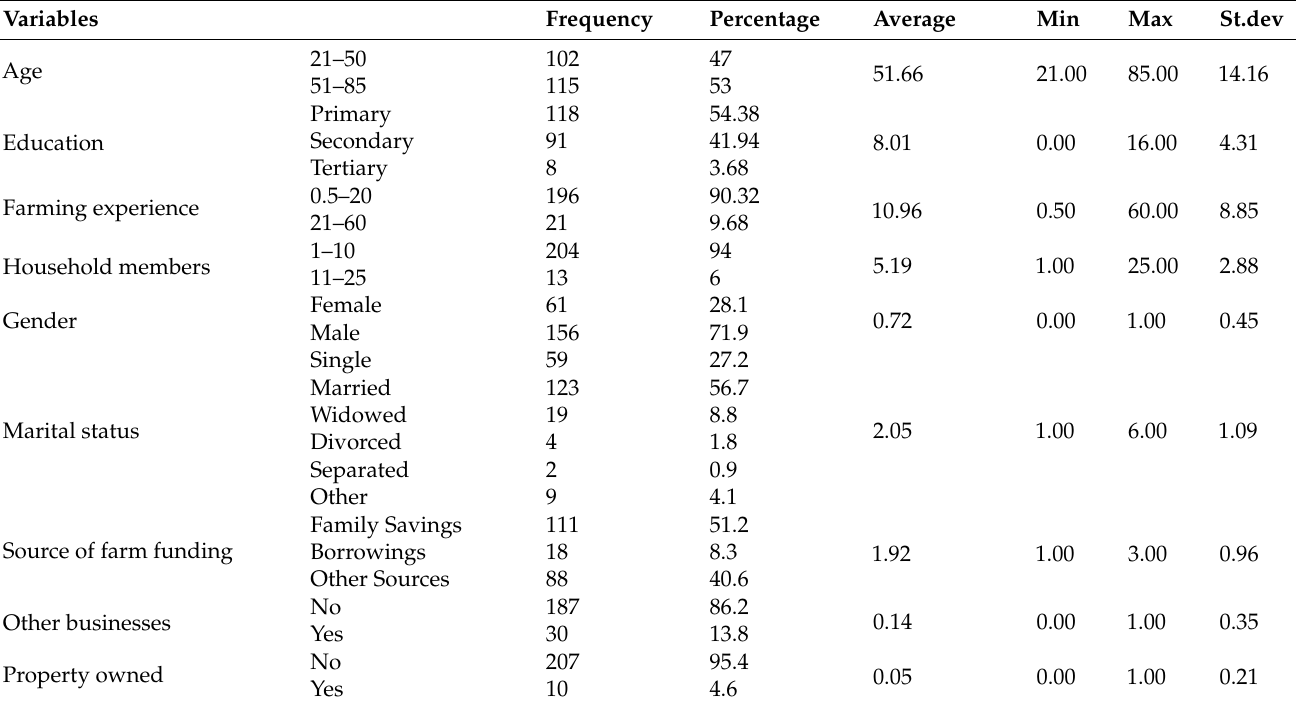
Table 3. Socio-economic characteristics of the respondents ( n = 217).